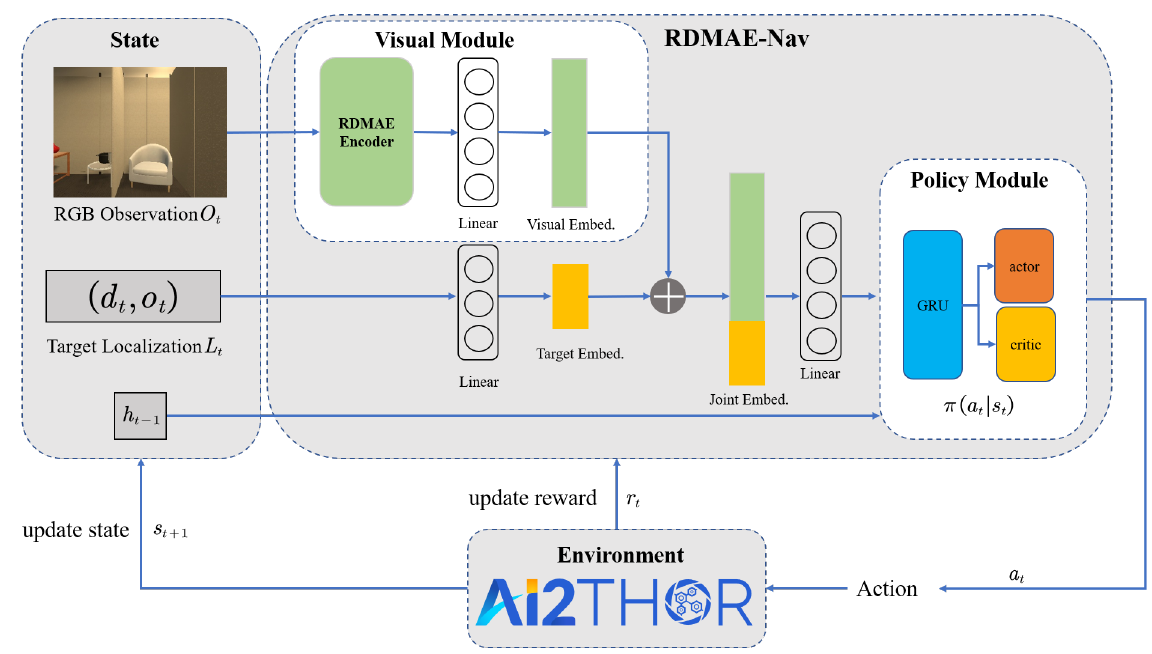
Figure 2. Overview architecture of RDMAE-Nav